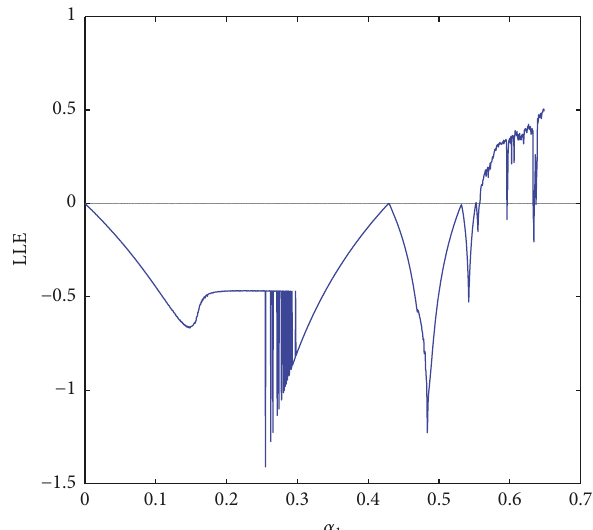
Figure 3: The largest Lyapunov exponent (LLE) plot of the supply chain system (10) with the adjustment speed 𝛼 1 .